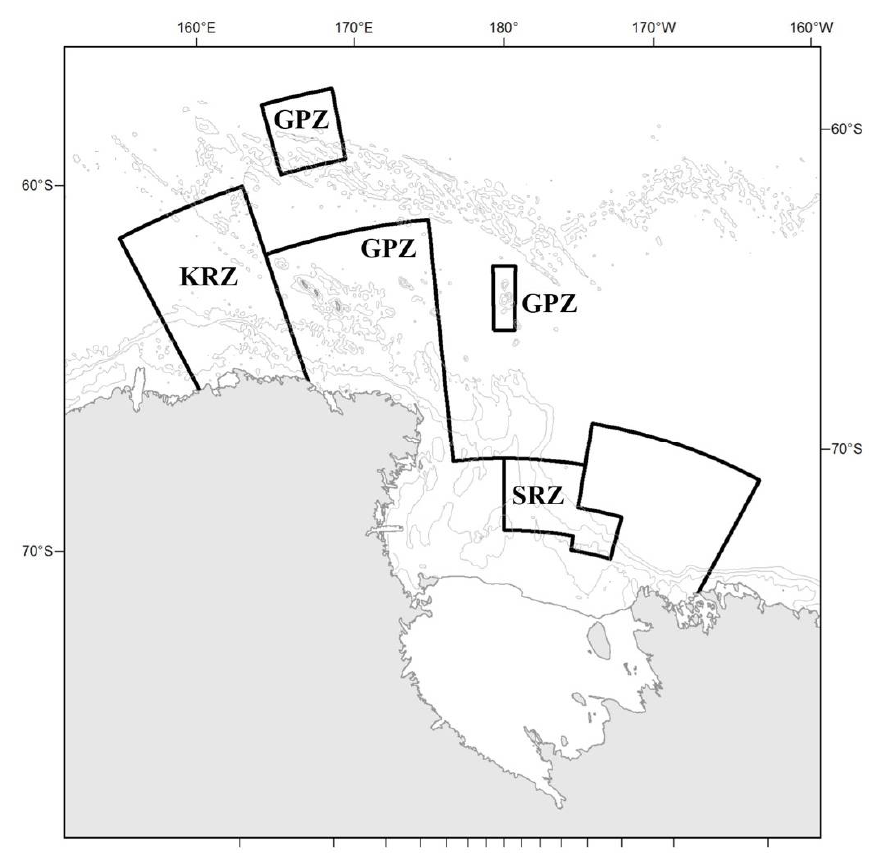
Figure 1. Ross Sea region marine protected area (RSRMPA) boundaries (other than coastlines) in black, including management zones: General Protection Zone (GPZ; three areas), Special Research Zone (SRZ), and Krill Research Zone (KRZ).